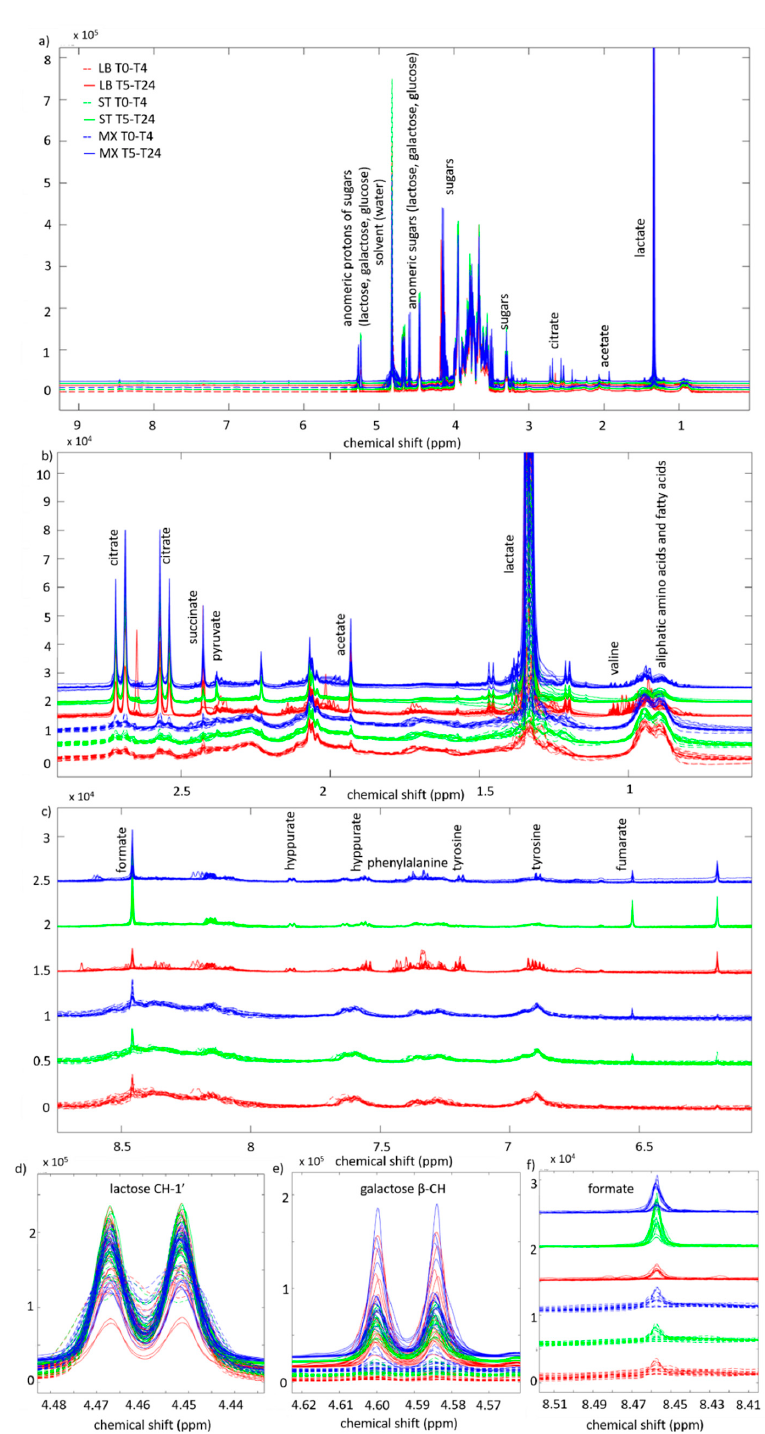
Figure 1. ( a ) Pre-aligned normalized spectra for the first five time-points (T0–T4) and the last five (T5–24) represented respectively with dotted or full lines. Spectra are colored according to strain: LB in red, ST in green and MX in blue. ( b ) Zoomed-in aliphatic (0.6–3 ppm) and ( c ) aromatic (6–9 ppm) regions are also presented, together with some significant signals: lactose (4.44–4.48 ppm) ( d ), galactose (4.57–4.62 ppm) ( e ) and formate (8.41–8.51 ppm) ( f ). The six different spectral sets are represented with a small offset on the vertical axis to better visualize differences.